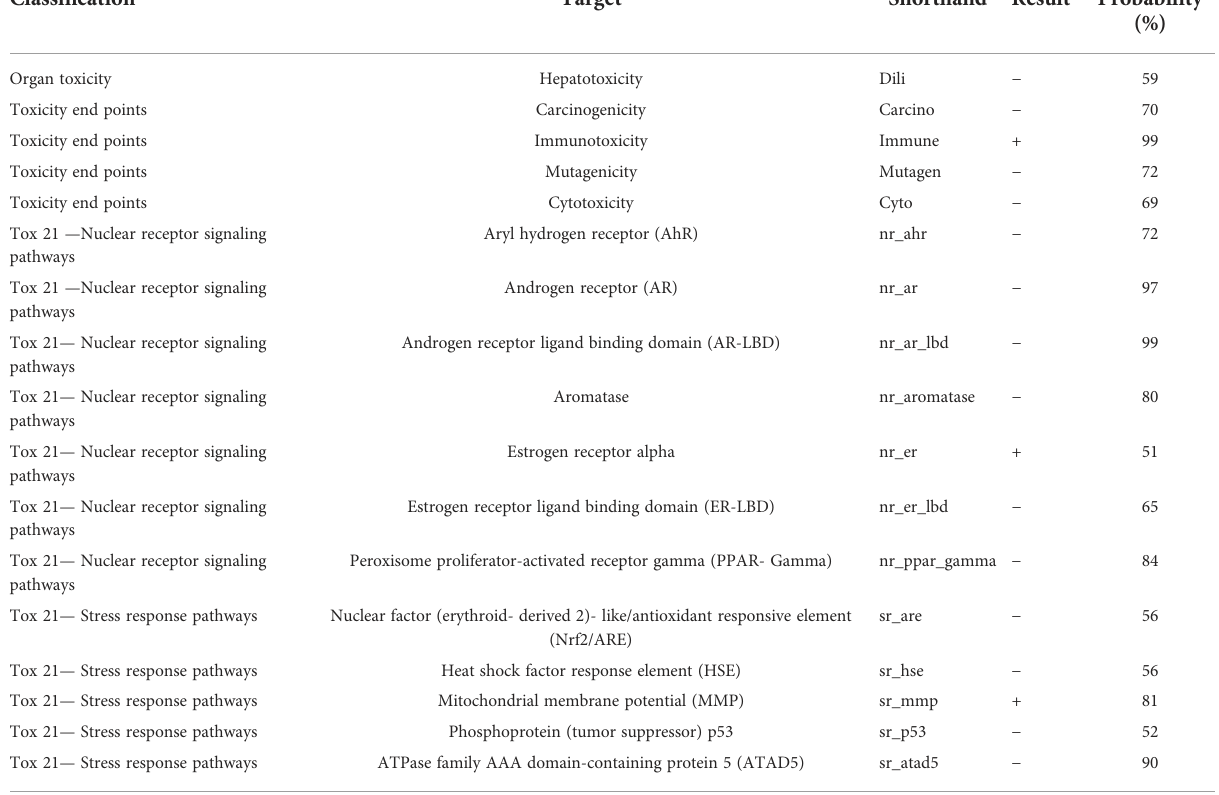
TABLE 4 Toxicity model report of